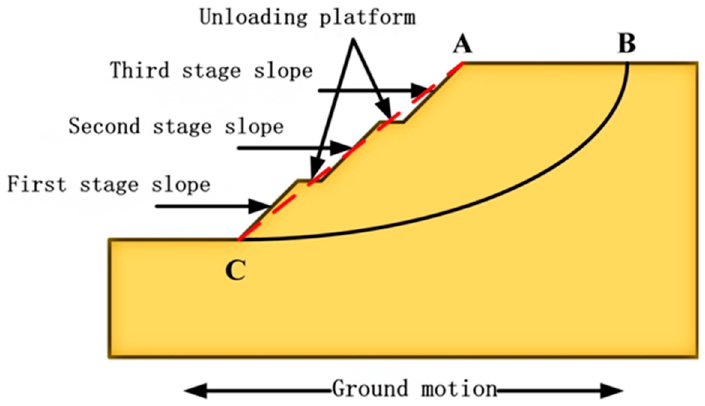
Figure 5. Sliding system of multi-stage loess slope under seismic